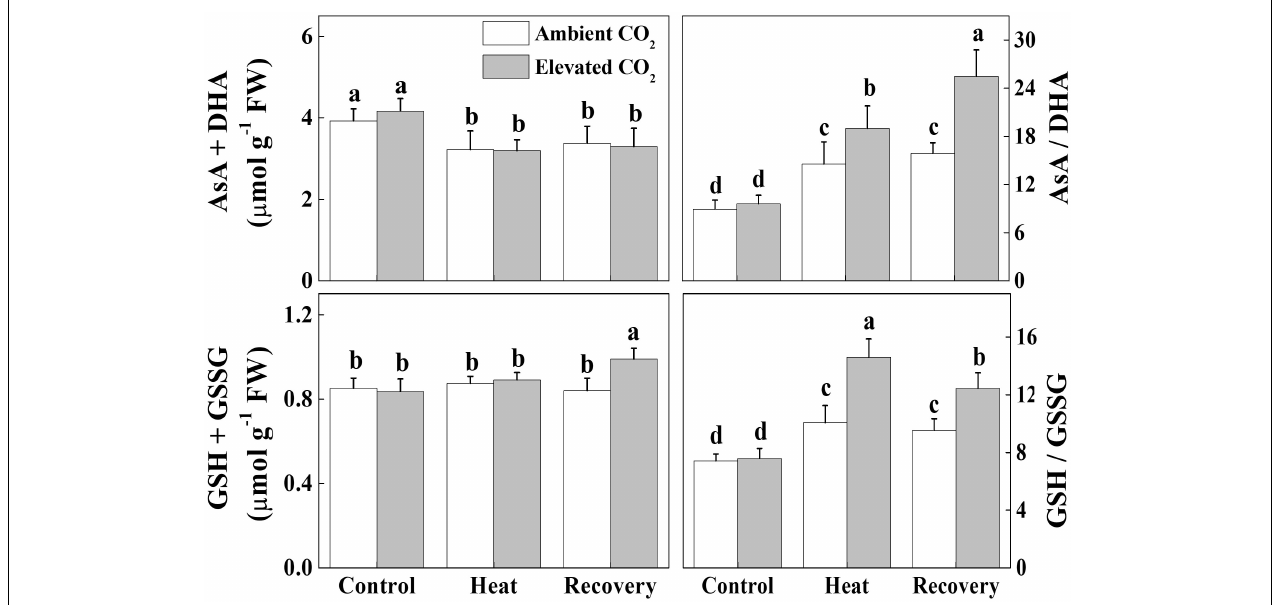
FIGURE 6 | Effects of elevated CO 2 and heat stress either alone or combined on the ascorbate-glutatione (AsA-GSH) pool and redox state in tomato leaves. Leaf samples for biochemical analysis were harvested after 24 h heat treatment and at 24 h recovery after the heat stress along with the control. Data are the means of four replicates ( ± SD). Mean denoted by different letters indicate significant differences between the treatments ( P < 0.05). Ascorbate, AsA; dehydro ascorbate, DHA; GSH, reduced glutathione; GSSG, oxidized